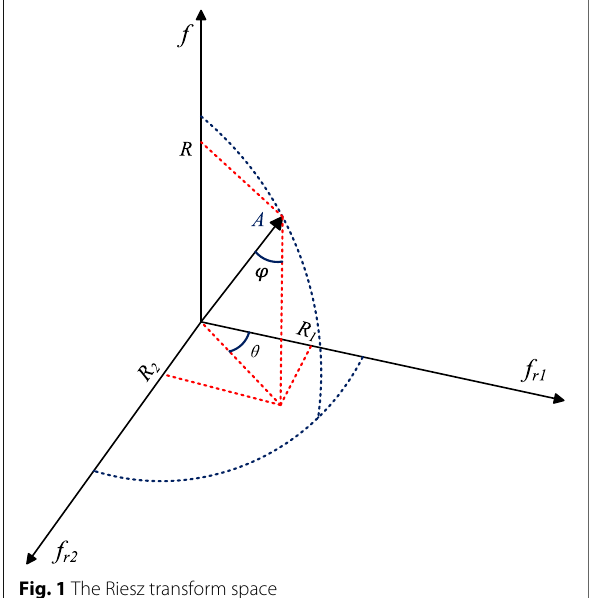
Fig. 1 The Riesz transform space